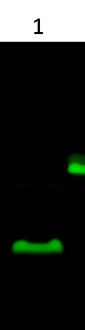
Figure 7. Dimer formation of ScSuFP in solution revealed by pseudo-native gel-electrophoresis. eGFP and Kaede were used as a control of monomer and obligatory tetramer, respectively. The photograph was taken through ALSC-56 filter under blue light illumination at 480 nm. Molecular weight standards are shown on the left of the gel. Lanes: 1—eGFP (monomer); 2—ScSuFP; 3—Kaede (tetramer).